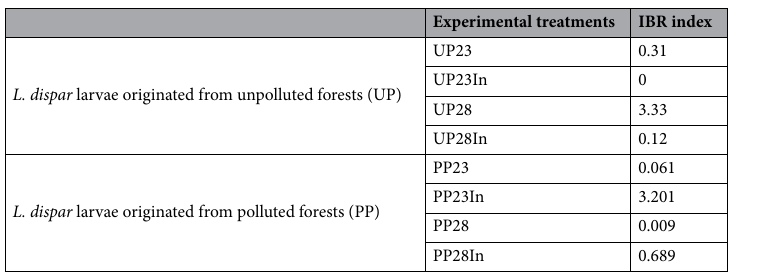
Table 1. IBR index values for midgut alkaline phosphatases (ALP), midgut total acid phosphatases (total ACP) and brain tissue hsp70 for 5th instar Lymantria dispar larvae exposed to different temperature